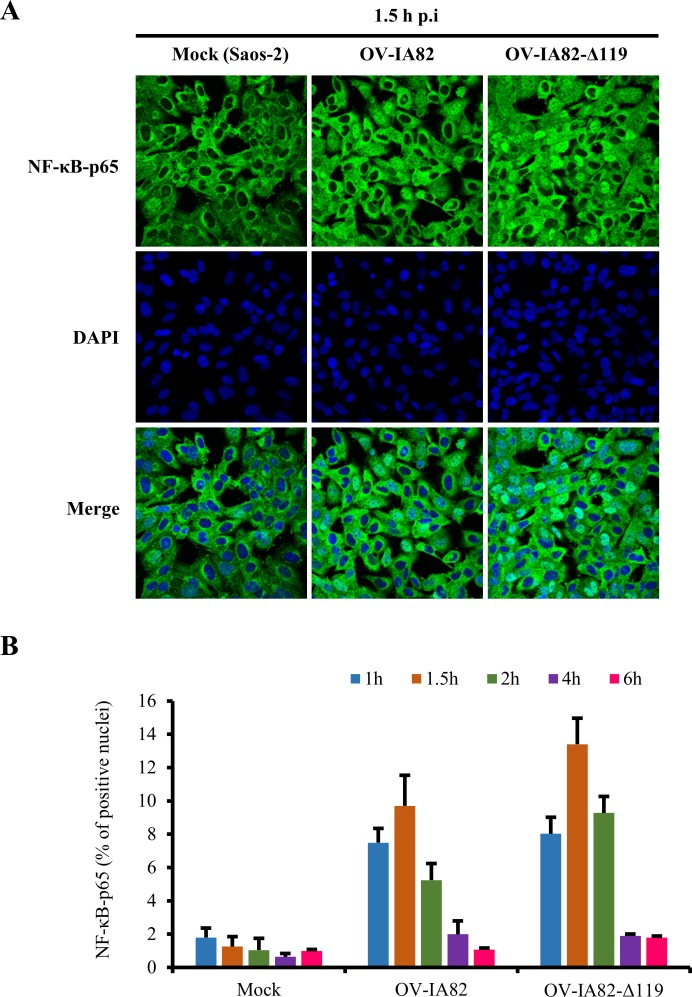
pRb affects ORFV119-mediated inhibition of NF-κB signaling in Saos-2 cells (A) Saos-2 cells were mock infected or infected with wild-type OV-IA82 or OV-IA82Δ119 (MOI, 50), fixed 1 h p.i. sequentially probed with primary antibody against NF-κB-p65 and Alexa Fluor 488 labeled secondary antibody, and counterstained with DAPI. Green, NF-κB-p65; Blue, DAPI. (B) Cells were counted (n = 500 cells/slide) and results are shown as percentage of cells expressing nuclear NF-κB-p65. Results are mean values from two independent experiments. p values for OV-IA82 vs OV-IA82Δ119 comparisons at all-time points were not significant.